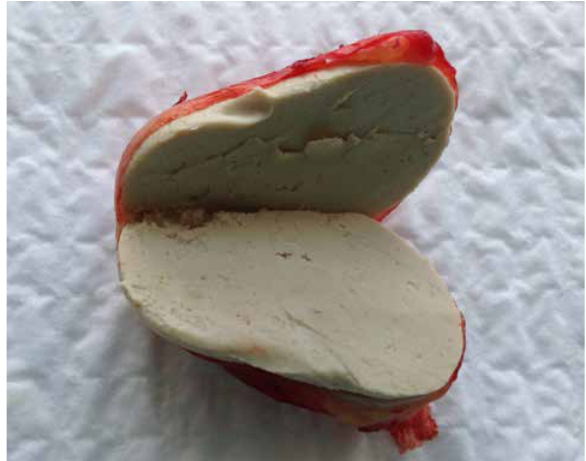
Figure 3: A 6-year old boy. Dissected surgical specimen of the lesion in the left submental region. Cheesy, epidermoid content can be seen